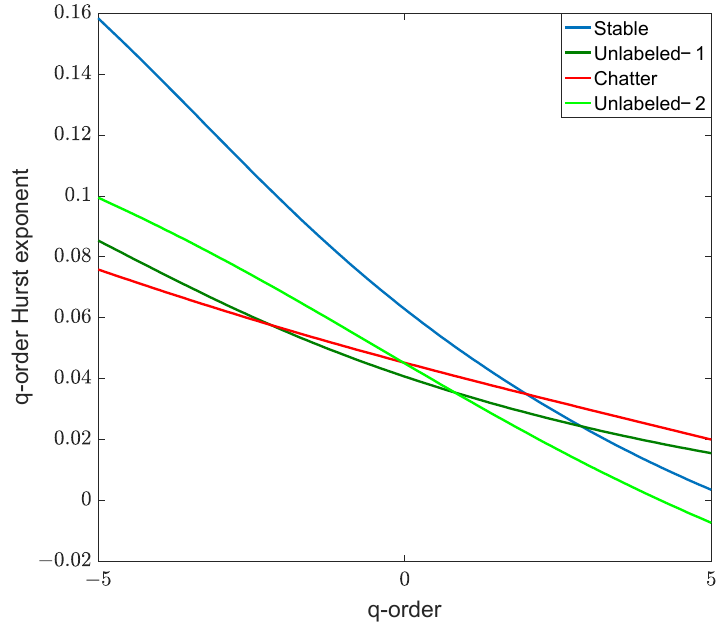
Figure 5. Generalized Hurst exponent curve of different chatter states.